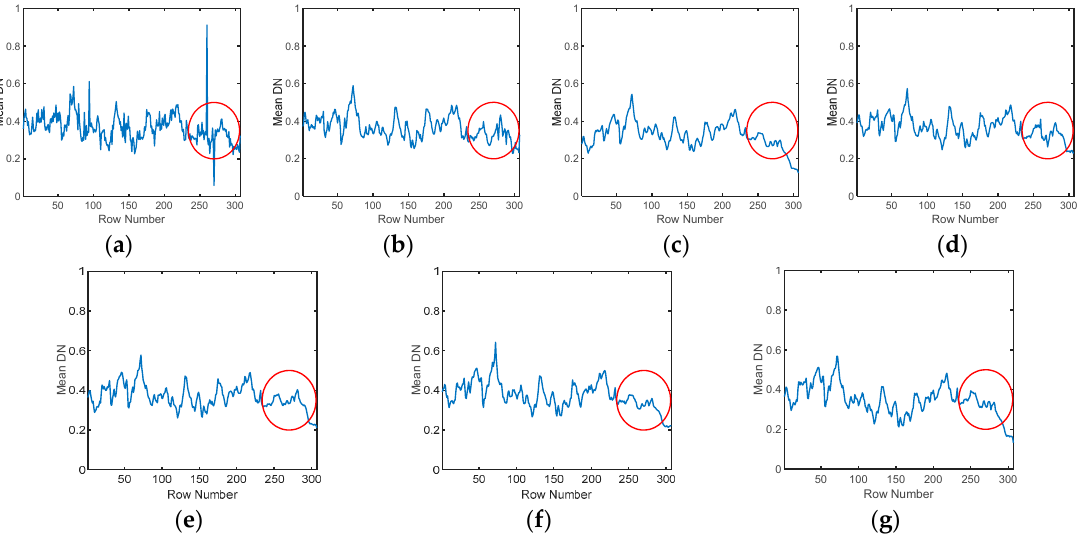
Figure 9. Vertical mean profiles of the denoising results of the 206 spectral band in the Hyperspectral Digital Imagery Collection Experiment (HYDICE) urban image: ( a ) original, ( b ) HyRes, ( c ) LRTV, ( d ) LRMR, ( e ) NAILRMA, ( f )LRTDTV, and ( g ) proposed.